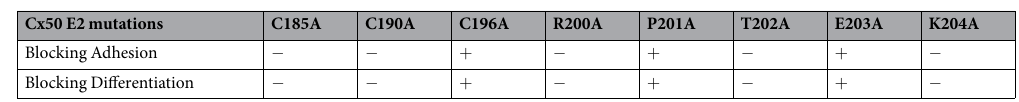
Table 2. Summary of the effect of